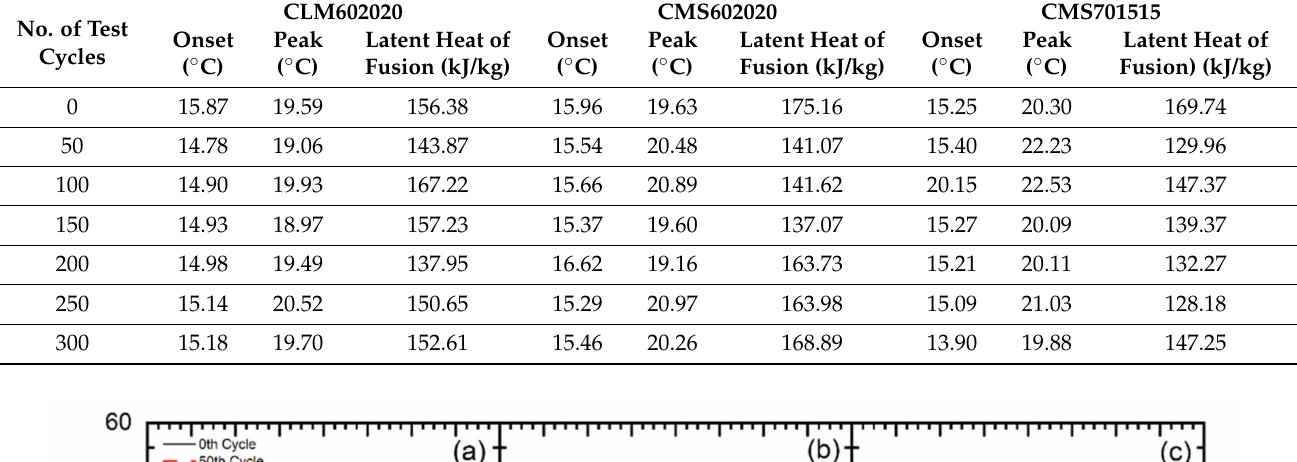
Table 4. Latent heat of fusion and melting temperature of developed materials with test cycles (CLM602020, CMS602020, CMS701515).